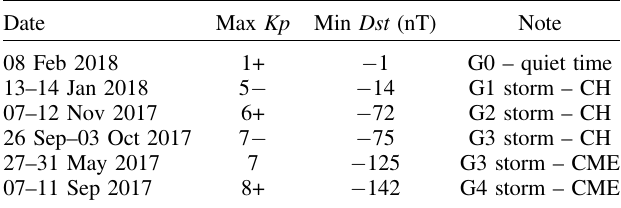
Fig. 9. Model performance against Final Global TEC product provided by the Universitat Politècnica de Catalunya (UPC) for the period June 2017 to May 2018: (a) distribution of TEC difference (forecast-actual), statistical parameters are reported together with a red line indicating the mean; (b) map of the mean values of the TEC difference (forecast-actual); (c) time pro fi le of the RGEC parameter, the black dashed line indicates the zero reference value; (d) map of the standard deviation of the TEC difference (forecast-actual). Table 3. Selected dates for the validation. Maximum Kp and minimum Dst of the period is also reported together with a note on the event features (CH = Coronal Hole; CME = Coronal Mass